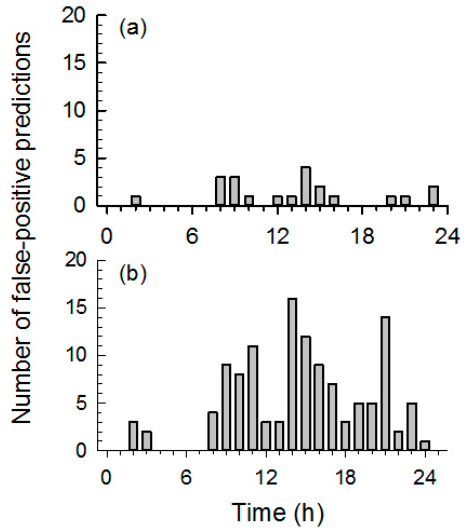
Figure 7. The incidence of false-positives during each 1-hr time interval for ( a ) the spectral analysis method and ( b ) the temporal analysis method. The horizontal axis represents the GTCS detection time from 00:00 to 24:00, and the bin width is set to 1 h.